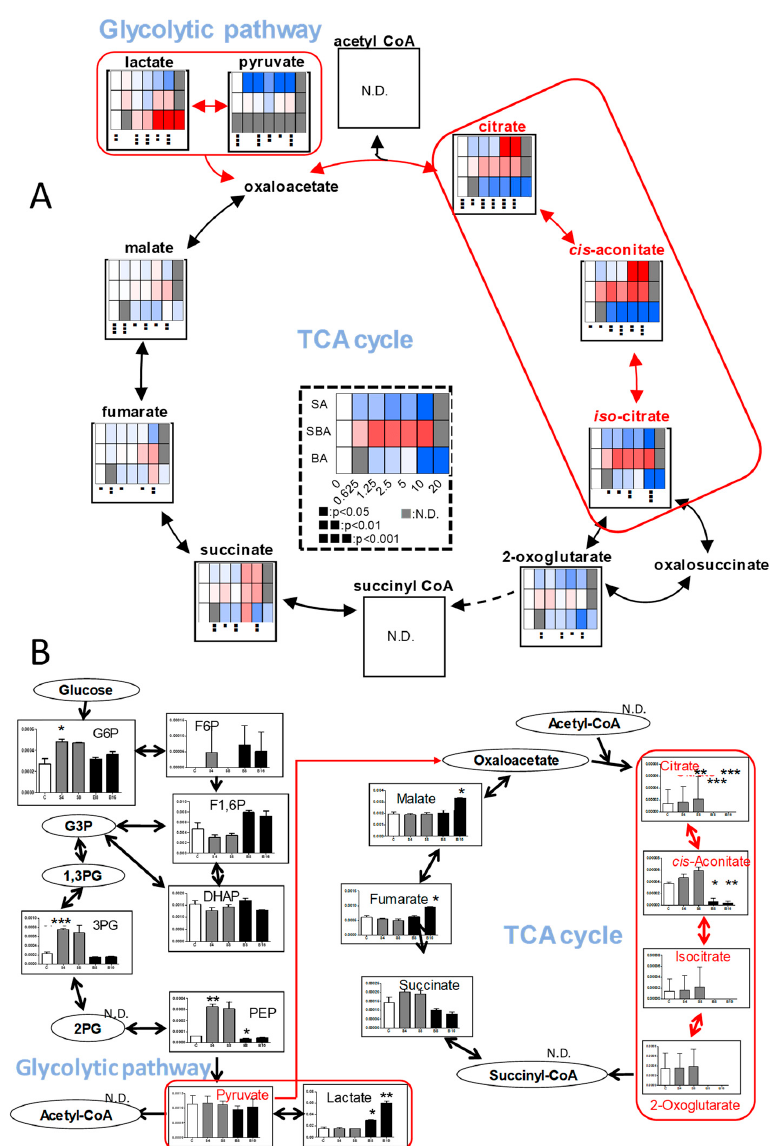
Figure 5. BA, but not SAB nor SA, inhibits the tricarboxylic acid (TCA) cycle. ( A ). Dose-response of SBA (60 min), BA (90 min), SA (30 min). HSC-2 cells were treated as Exp. I in Materials and Methods. Averaged values of quantified metabolites (amol/cell) were calculated by triplicate. To visualize the data in heat maps, each of the values were divided by those of 0 mM, i.e. fold changes were visualized and colored. Blue, white, and red were assigned for the fold changes of 0, 1, and 2, respectively. For the treatments of 0.626 mM, Student’s t -tests were used, and for those of 20 mM, no statistical test was conducted. Not detected (N.D.) was colored in gray. One-way ANOVAs were conducted and black boxes were assigned below each heat map. ( B ). Dose-response of SBA and BA. HSC-2 cells were treated as Exp. II in Materials and Methods..Horizontal axis from left to right: C, S4, S8, B8, and B16 represent control, 4 and 8 mM SBA, 8 and 16 mM BA, respectively. Treatment time: 70 min. Control and each group were analyzed using Welch’s test (both tail) and p -values were adjusted by Bonferroni correction. * p < 0.05, ** p < 0.01, and *** p < 0.001. Error bar indicates standard deviation of triplicates. Within 90 min exposure to BA, intracellular concentrations of citrate, cis -aconitate, and iso -citrate declined to base-line level in HSC-2 cells, whereas that of succinate, fumarate, and malate maintained